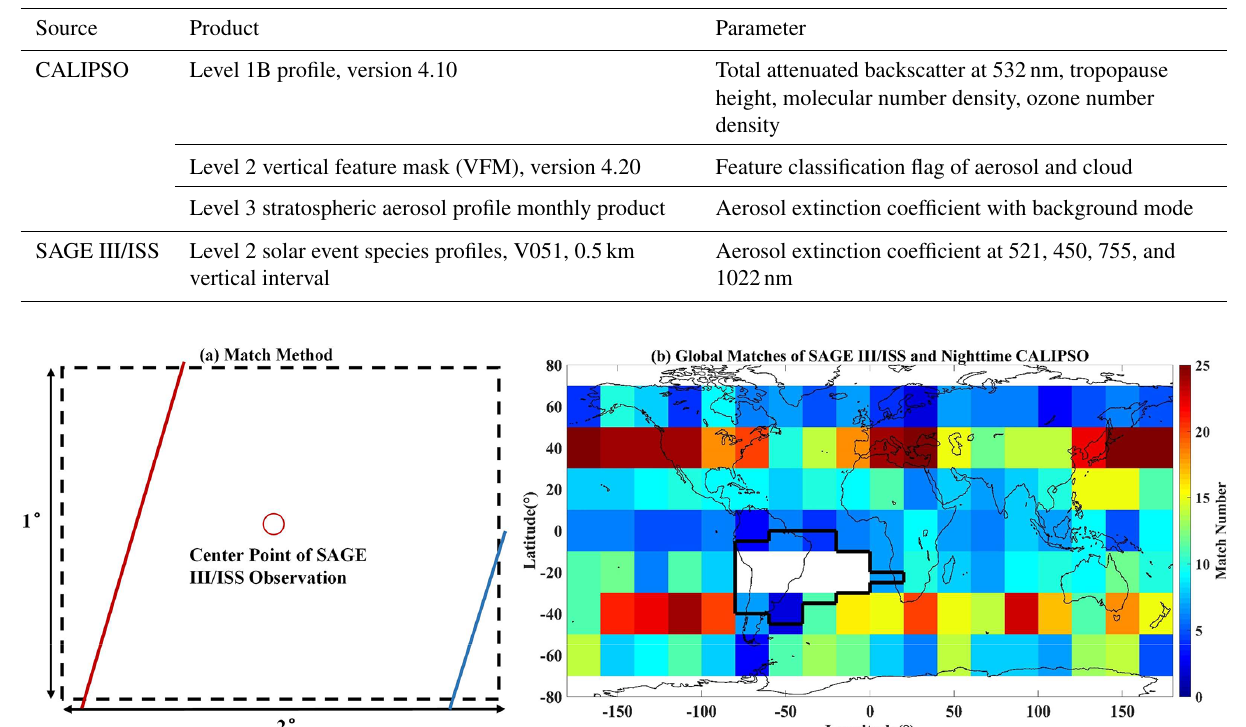
Table 1. Data used in the study with their sources and parameters. The tropopause height, molecular number density, and ozone number density are provided by the Global Modeling and Assimilation Office.